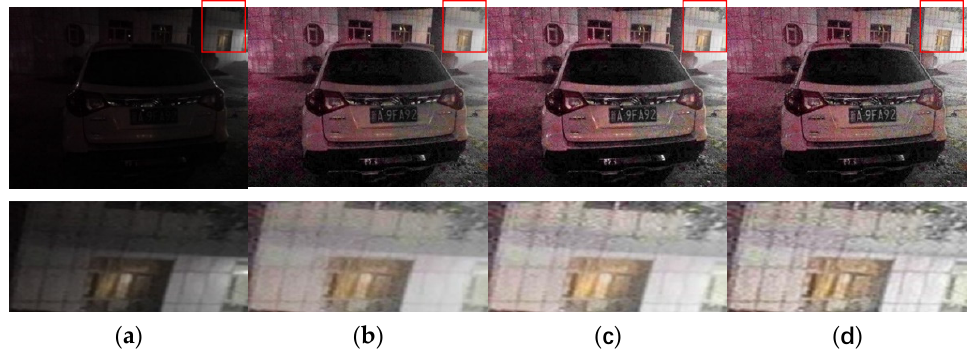
Figure 5. ( a ) Test image and its detail map; ( b ) soft-matting refined algorithm result and its detail map; ( c ) guided filter refined algorithm result and its detail map; ( d ) AnisGF refined algorithm result and its detail map.